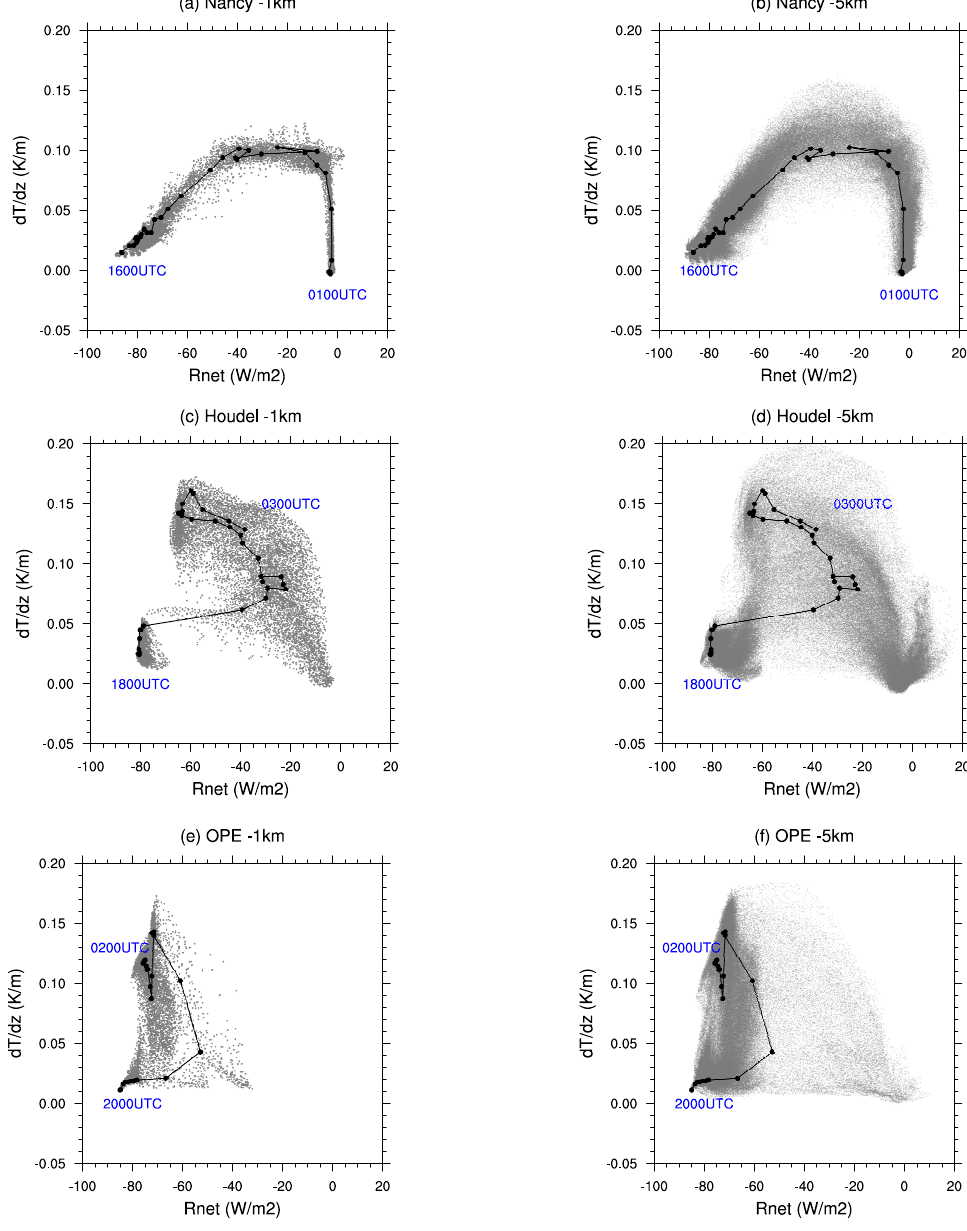
Figure 10. Pseudo-process diagrams between the modelled net radiation fluxes at the surface (Rnet) and modelled surface layer stability (dT/dZ) for the three observation sites : Nancy ( a , b ), Houdel ( c , d ) and OPE ( e , f ). Diagrams are plotted over an area of 1 km 1 km (left panel: a , c , e ) and over an area of 5 km 5 km (right panel: b , d , f ). The trajectory for the observed site is plotted by solid line.